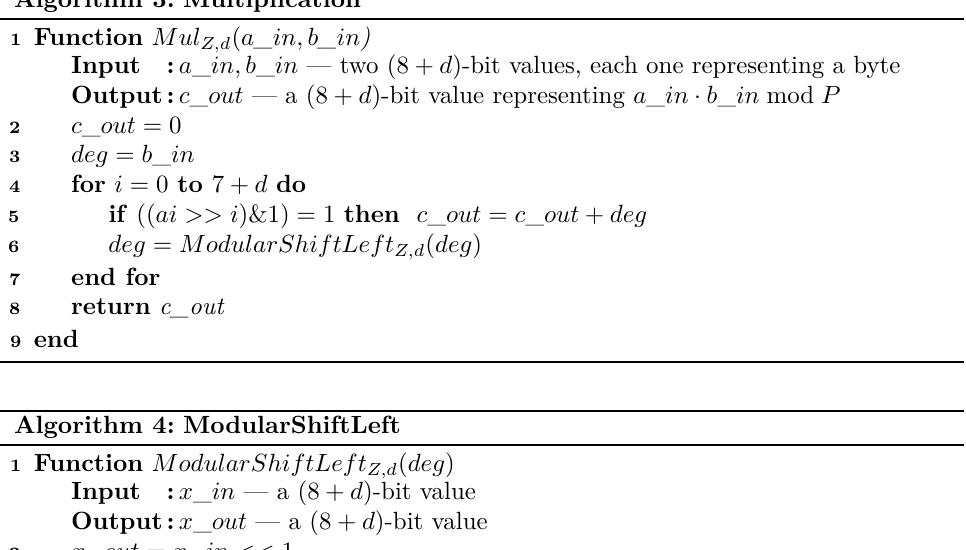
Redundancy AES Masking Basis for Attack Mitigation